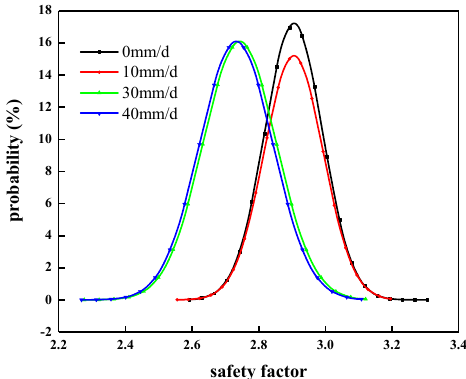
Figure 13. Probability distribution of slope safety factor.